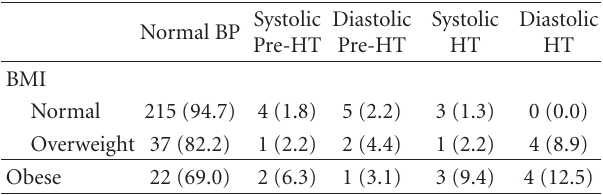
Table 3: Blood pressure classification according to BMI category.